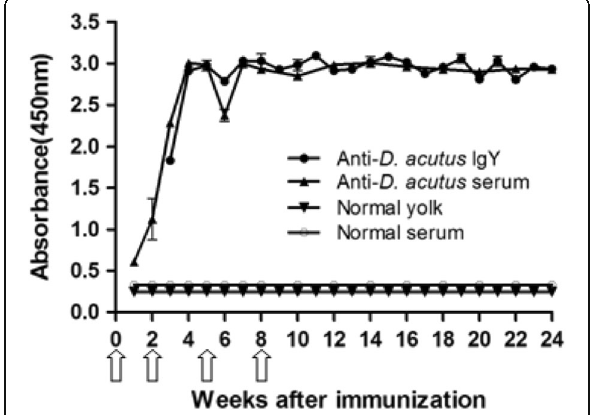
Fig. 1 Primary and secondary antibody response in serum and egg yolk of hens immunized with D. acutus venom. The activity against D. acutus venom of serum and WSF was assessed by ELISA. The white arrows indicate immunization